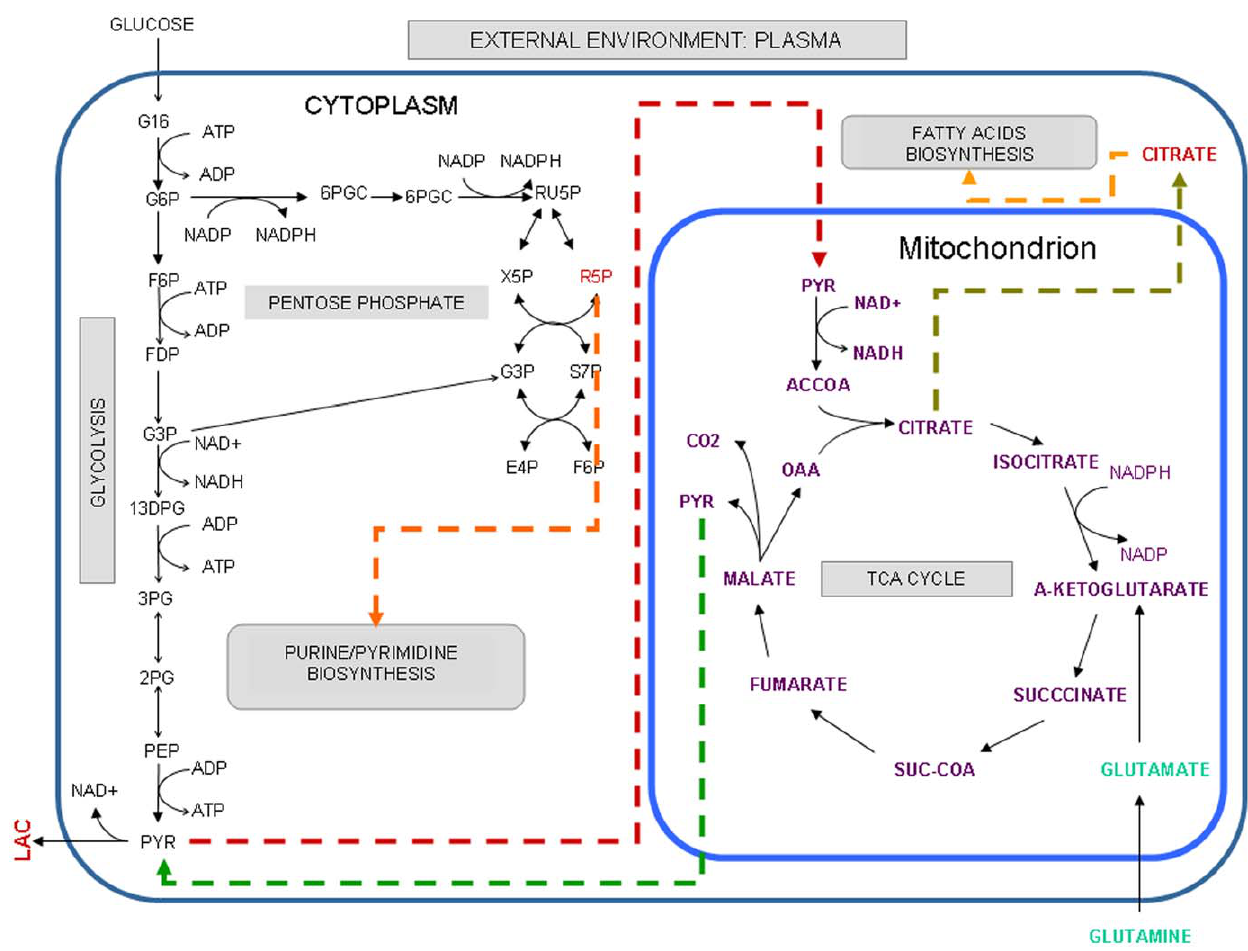
Figure 1. Metabolic pathways with a significant role in cancer cells. As a result of a bibliography search, we have selected those metabolic pathways that potentially can constitute a metabolic core on most cancer cells. Orange, red and green dashed lines indicate metabolites that participate in other biosynthetic pathways, metabolites that can be transported from cytoplasm to mitochondrion and metabolites that can be transported from mitochondrion to cytoplasm, respectively. Compartment information has been denoted by external environment [e], cytoplasm [c] and mitochondria [m]. The set of reactions that integrates this reconstruction are listed in Table S1.